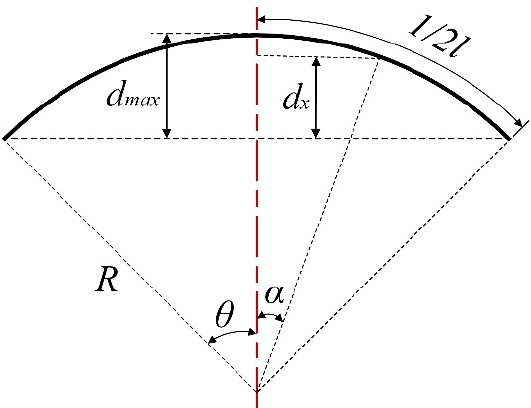
Figure 3. Geometric relation of workpiece bending distortion.